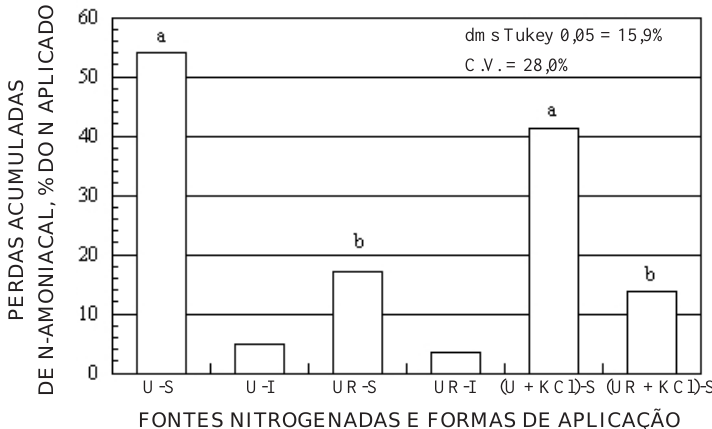
Figura 2. Perdas acumuladas de N-amoniacal provenientes da aplicação superficial (S) e incorporada (I) das fontes uréia (U); uran (UR); uréia + KCl (sólida) e uran + KCl (fluida) na cobertura nitrogenada de milho em sistema plantio direto. Médias com letras minúsculas desiguais diferem significativamente pelo teste de Tukey 5,0%. Colunas sem letras não foram incluídas na análise